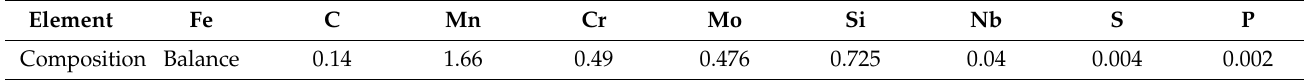
Table 1. Chemical composition of the experimental steel (in wt.%).